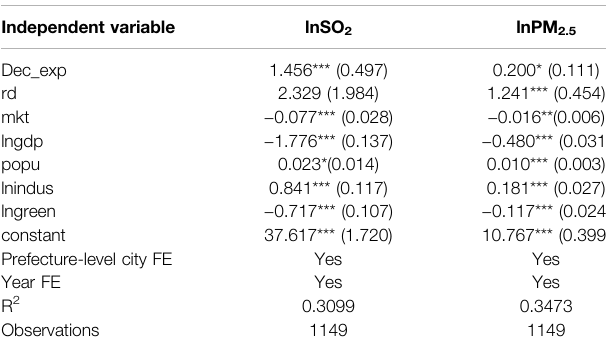
TABLE 2 | Descriptive statistics. TABLE 3 | Main